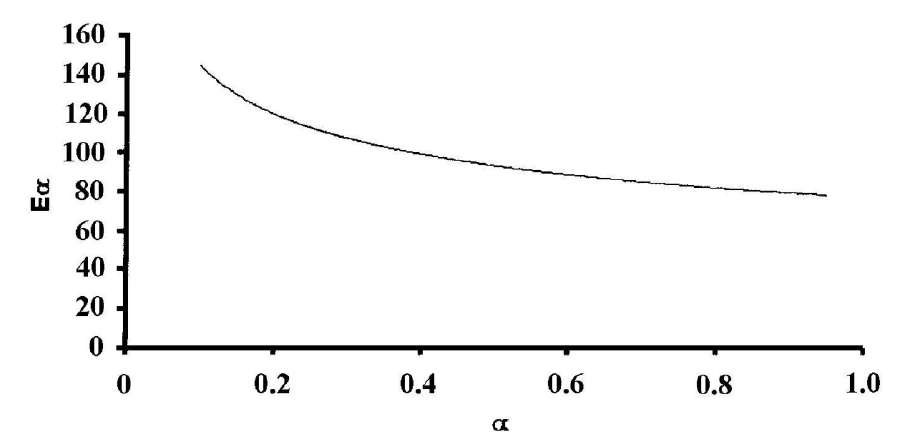
Figure 3. Activation energy Ea Vs  curves for un-irradiated and γ -irradiated sliver